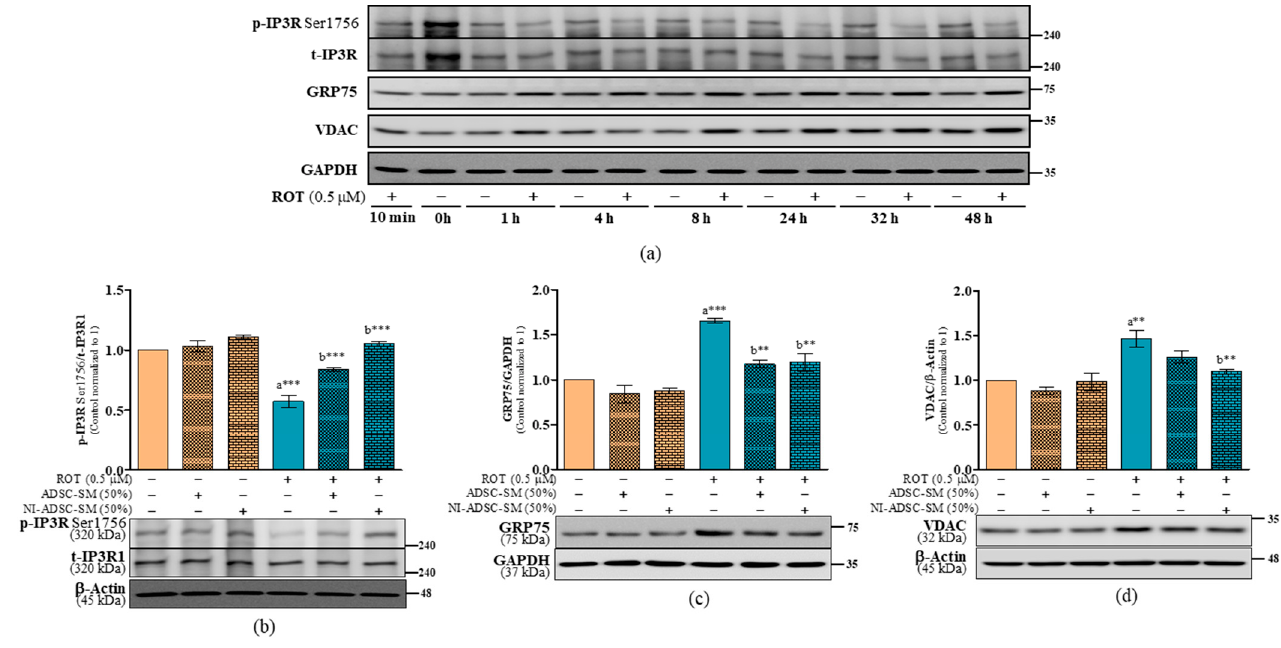
Figure 11. Effects of the NI-ADSC-SM on ER–mitochondrial signaling proteins. Cells treated with or without ROT (0.5 µ M) at different timepoints were assessed for IP3R1, GRP75, and VDAC expression by Western blotting ( a ). Cells were incubated in the presence of ROT (0.5 µ M) or DMSO for 48 h alone or with the ADSC-SM or NI-ADSC-SM (each diluted by 50%) during the last 24 h. The levels of p-IP3R Ser1756/t-IP3R1 ( b ), GRP75/GAPDH ( c ), and VDAC/ β -actin ( d ) protein expression were assessed by Western blotting. Data are shown as the means (bars) and SEM (error bars) of three independent cell culture experiments. Statistical analysis was performed using one-way ANOVA with Tukey’s post-test. Statistical comparisons: a—compared with control; b—compared with ROT; ** p < 0.01 and *** p < 0.001. p-, phosphorylated; t-, total.